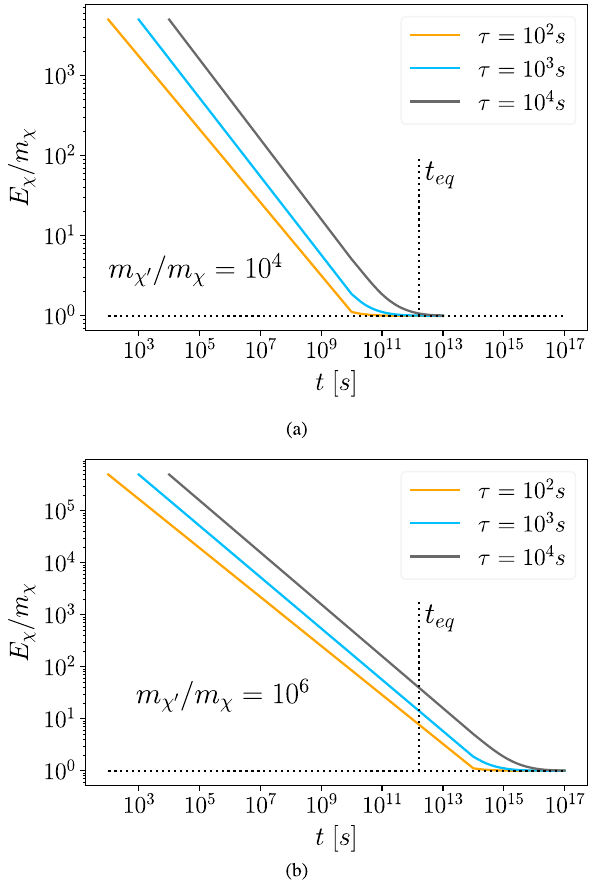
Fig. 2 Time evolution of dark matter energy. We consider situations where dark matter mother lifetime is τ = { 10 2 s , 10 3 s , 10 4 s } and the ratio between dark matter mother and dark matter mass is m χ (cid:4) / m χ = { 10 4 , 10 6 } . In all situations of a dark matter is cold at matter-radiation equality ( t eq ) , while in b dark matter is hot in all scenarios